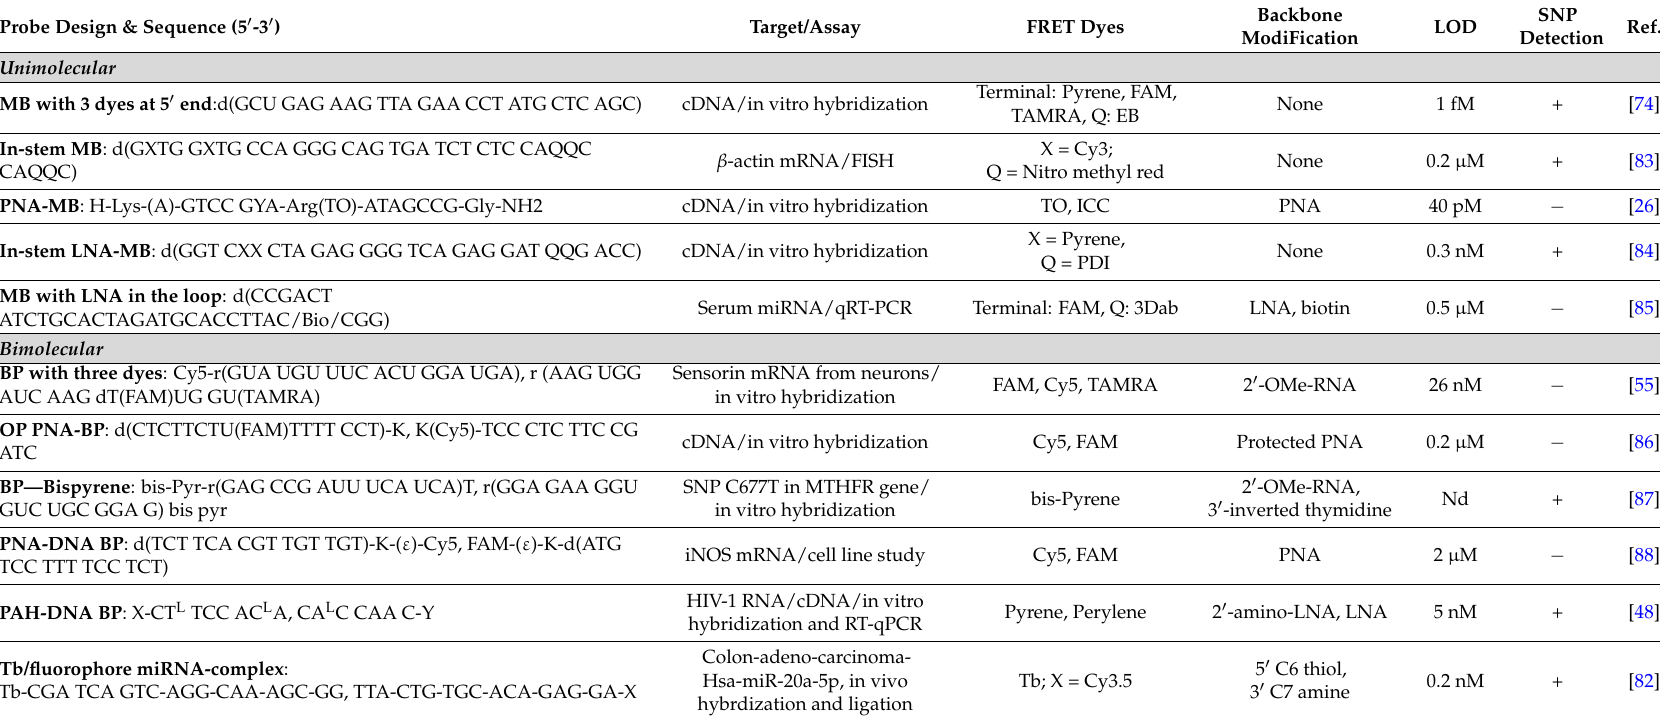
Table 1. Representative assays and FRET probe design for nucleic acid detection 1